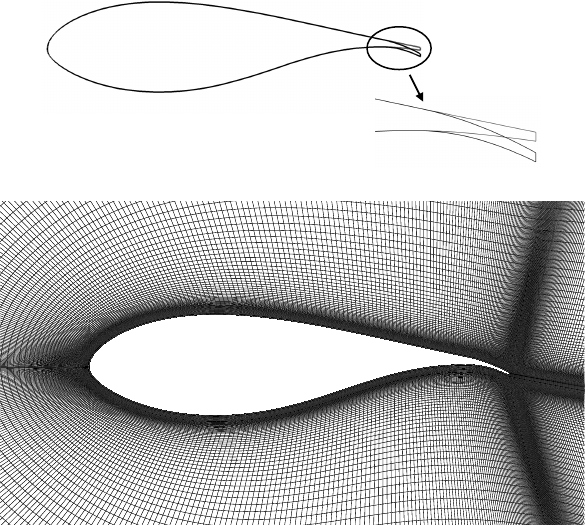
Figure 4. Methodology for 2-D deflection (Jost et al., 2016).